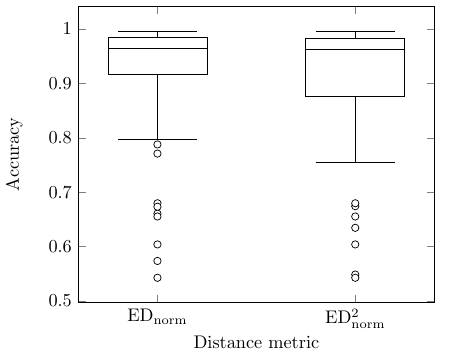
Figure 11. Accuracy of the PSF algorithm depending on the distance metric